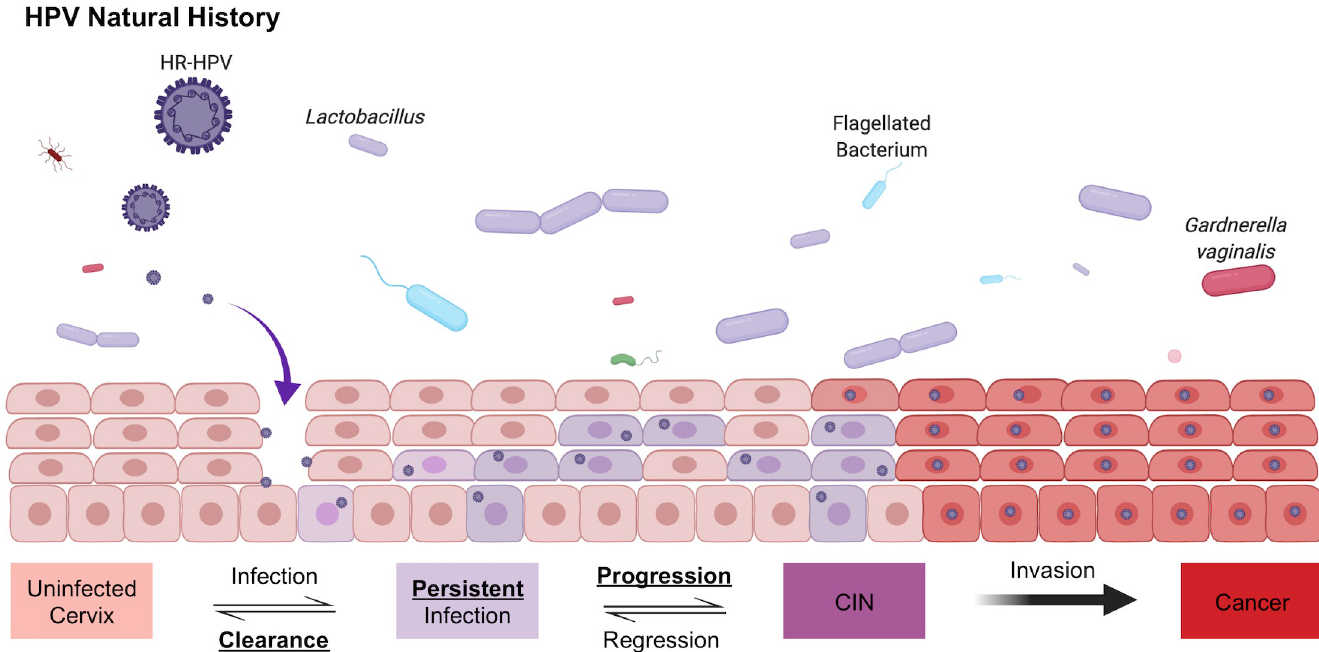
Fig 1. HPV natural history. The natural history of HR-HPV is depicted. Briefly, an incident HR-HPV infection can occur by entering the basal layer through an epithelial abrasion. Most incidence infections are cleared, however some remain persistent for years and decades. Persistence of a HR-HPV infection combined with known risk factors (e.g., smoking) may allow the persistent HR-HPV infection to progress to precancer (cervical intraepithelial neoplasia, CIN). If the lesion does not regress and the HR-HPV is able to successfully integrate into the host-cell genome, clonal expansion may occur and result in an invasive cancer.